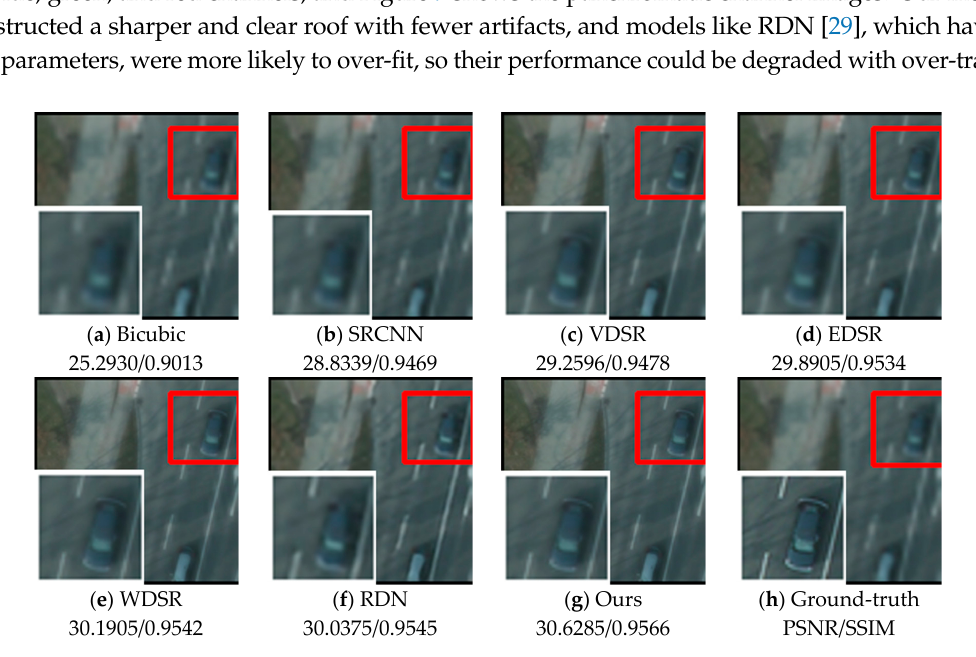
Figure 7. Qualitative comparisons of our model with other methods at the scale of × 3 on the COWC test